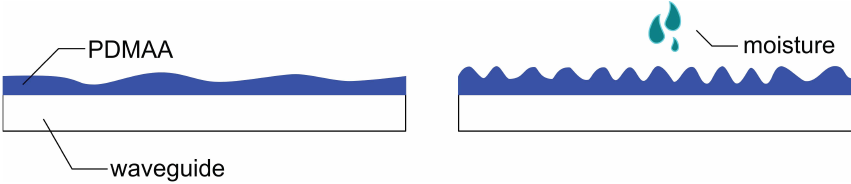
Figure 3. Behavior of the PDMAA cladding material upon water absorption. Due to an increase in volume, the surface roughness increases, leading to increased light scattering, which can either be detected as intensity loss of the propagating light field or as increase of the light signal in the environment of the